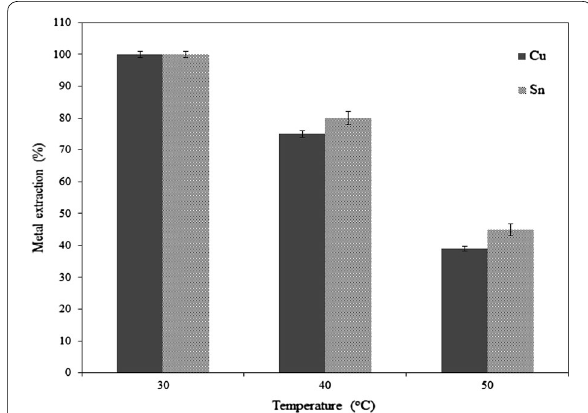
Fig. 4 Effect of temperature on metal recovery from Sn–Cu solder (100 mg) by 4 ml acetic acid (80%) at 150 rpm shaking speed and 30 h incubation